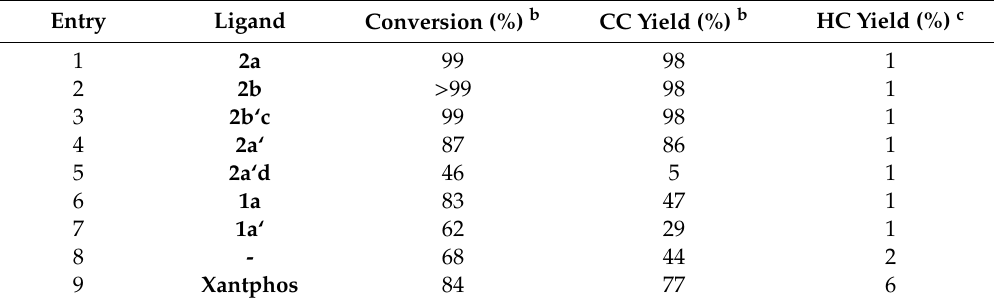
Table 3. Screening of pyrazolyl ligands for the SM cross-coupling reaction under optimised reaction conditions.